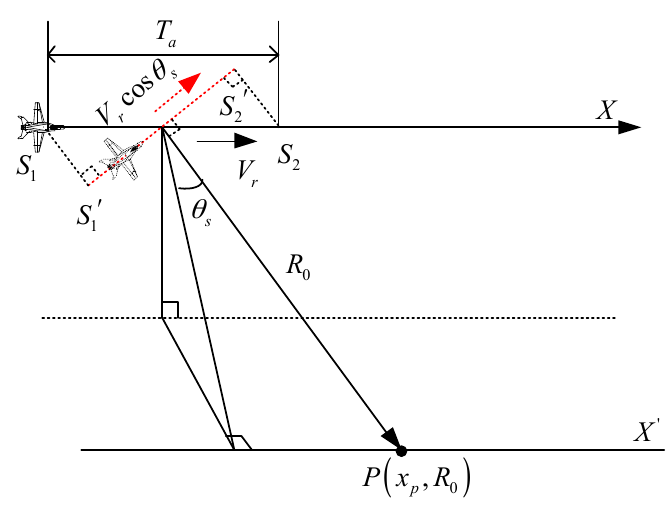
Figure 2. Geometry of squint SAR after the linear range walk correction (LRWC). The red dot line represents the equivalent trajectory of the platform after the LRWC.